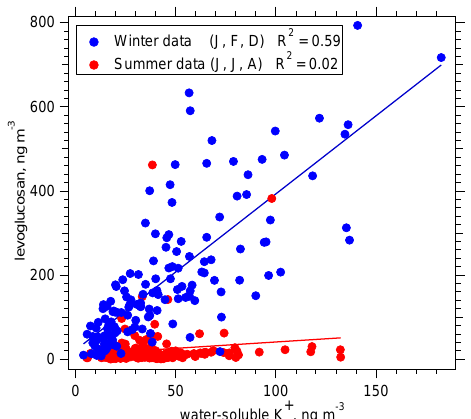
Fig. 5. Relationship between levoglucosan and water-soluble K + concentrations in winter (January, February and December) and summer (June, July and August). Data on 5 July 2007 were not plot- ted and excluded from the regression calculation due to abnormally elevated levels of K + associated with fourth of July